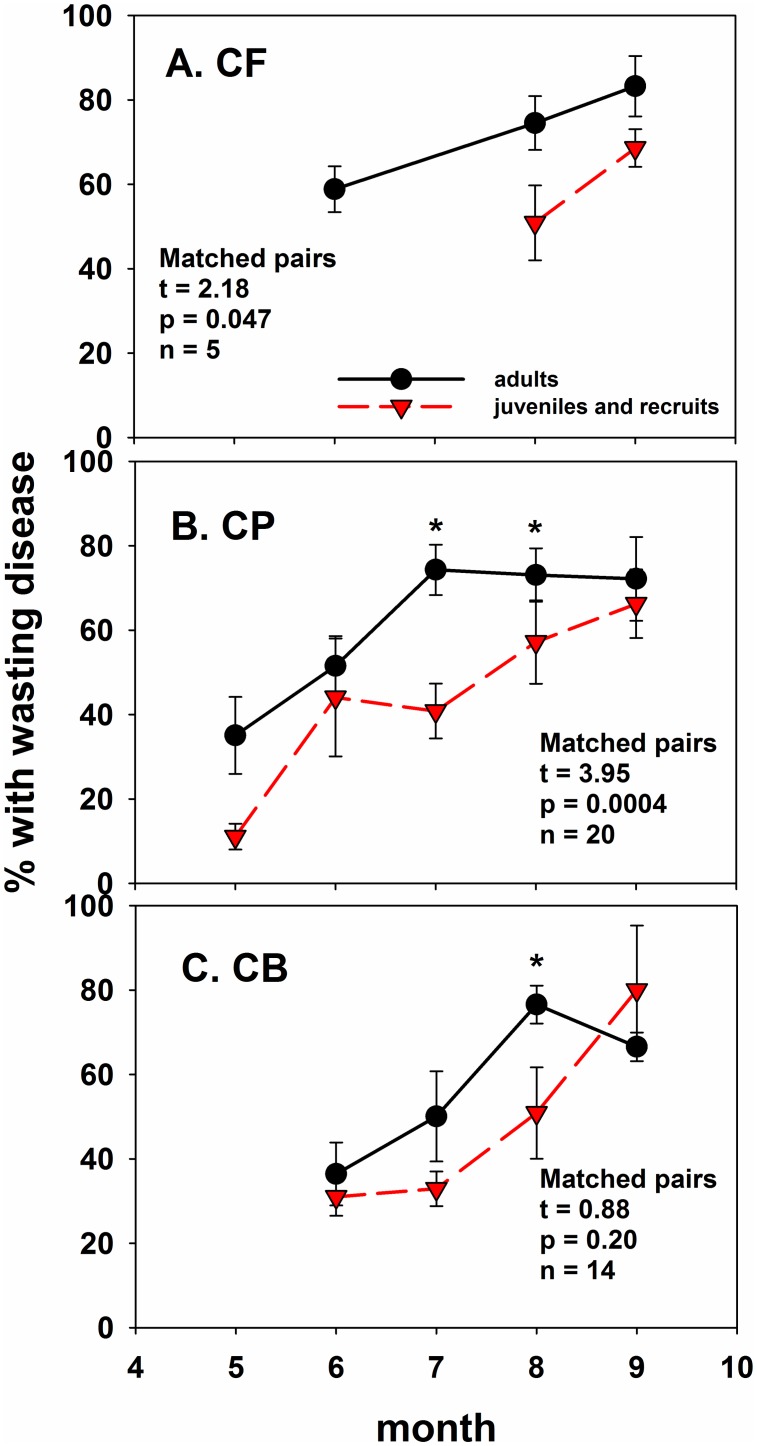
Frequency of small/juvenile P. ochraceus with wasting compared to frequency of adult P. ochraceus with wasting, averaged across sites within capes (± 1 SE).Asterisks indicate months in 2014 in which juveniles had lower % wasting, and matched pairs statistics indicate overall differences across months within capes. Data were sine-1 square root-transformed for analysis. If September data are dropped for CB, t = 3.33, p = 0.004, n = 11.